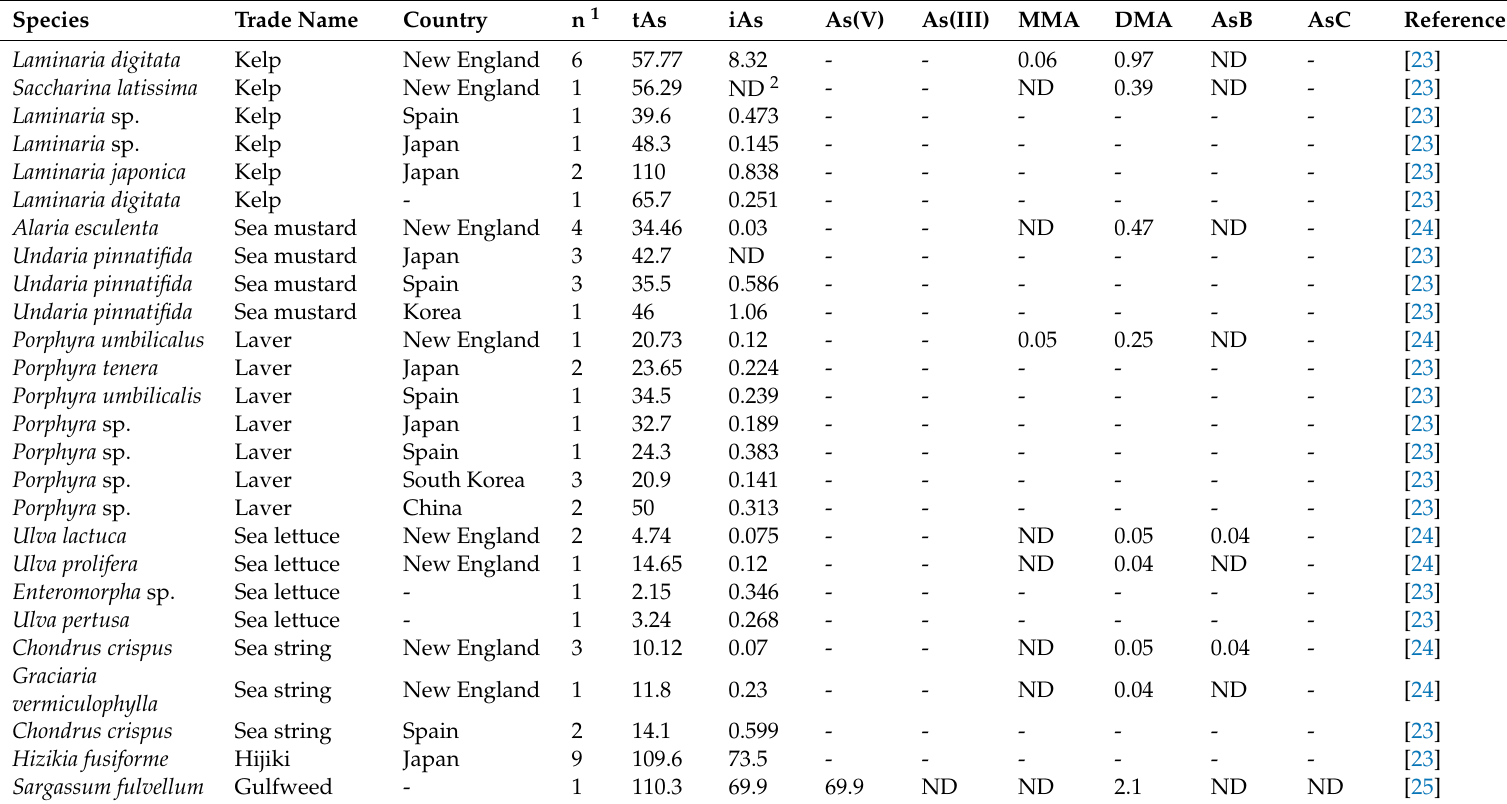
Table 3. Comparison of mean concentrations of arsenic species (mg kg − 1 DW) in this study with those reported in previous studies for similar seaweed samples.